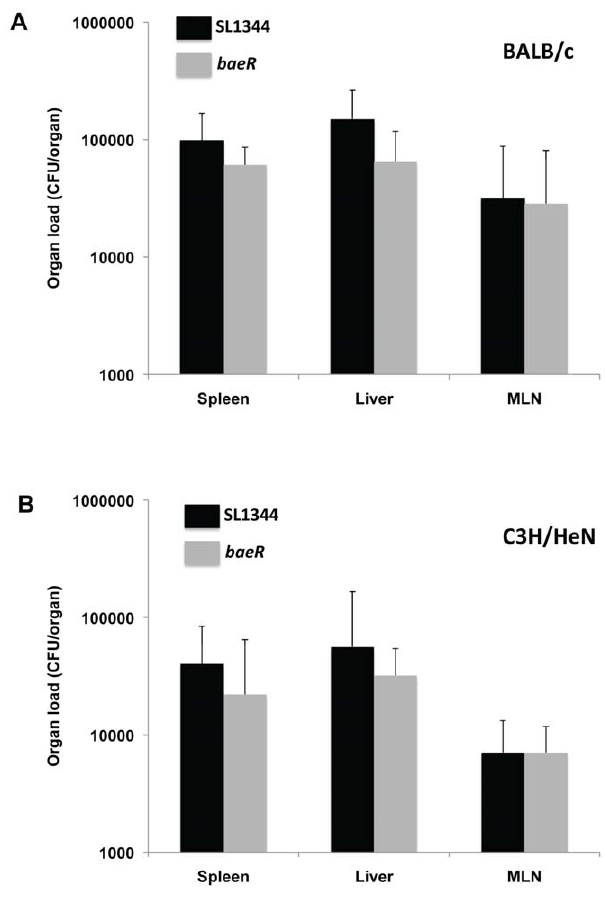
Figure 1.Oral infection of BALB/c and C3H/HeN mice. Mice were inoculated orally with either 5 6 10 5 CFU of the WT strain or the baeR mutant and the number of bacteria present in different organs determined 5d later for BALB/c and 10d later for C3H/Hen mice. The bar represents the mean of 5 mice and the error bar indicates the SD.